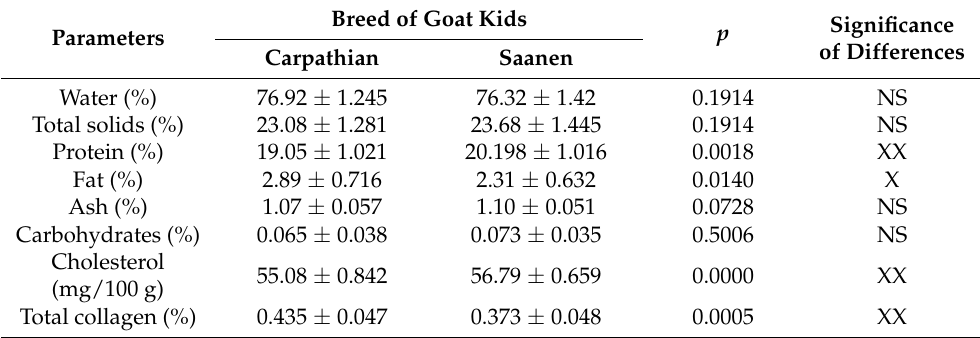
Table 1. Chemical composition of goat kid